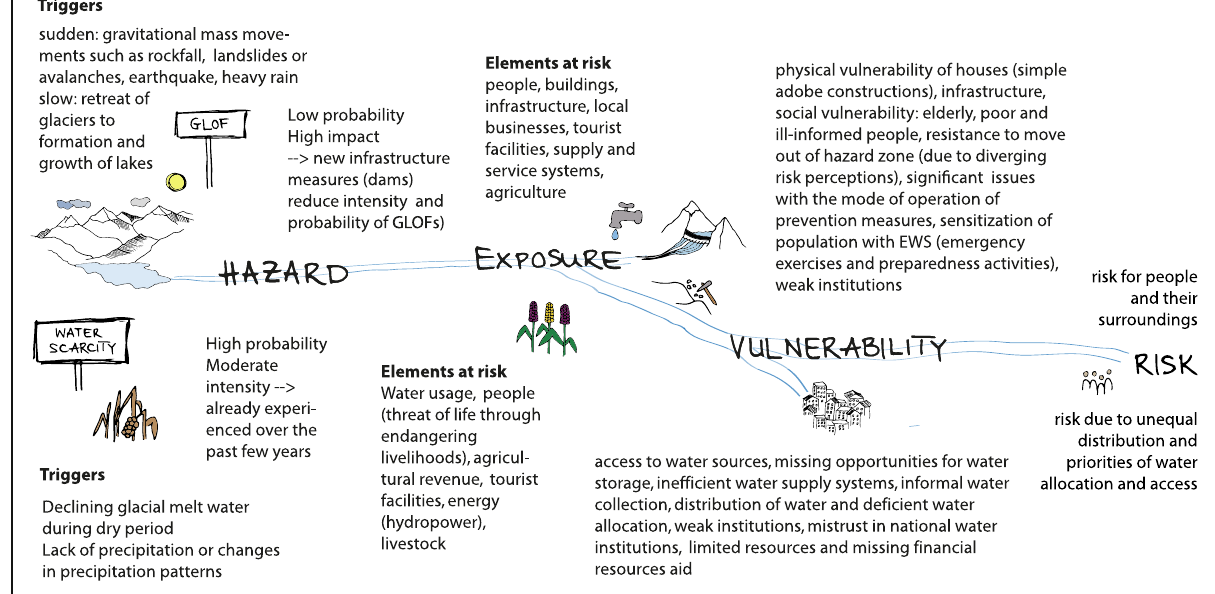
Fig. 8 Scheme of trigger, hazard, exposure, vulnerability and resulting risks for GLOF and water scarcity; These processes are connected on different levels such as water allocation (periodically), water reservoirs and management, damage of infrastructure by GLOFs influences water availability for the period of destruction, glacial retreat and